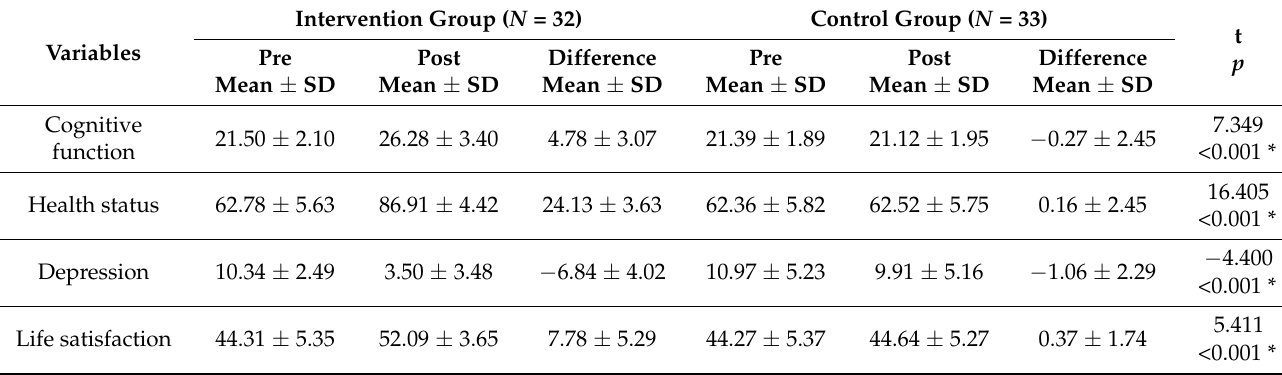
Table 4. Effects of cognition/exercise dual-task